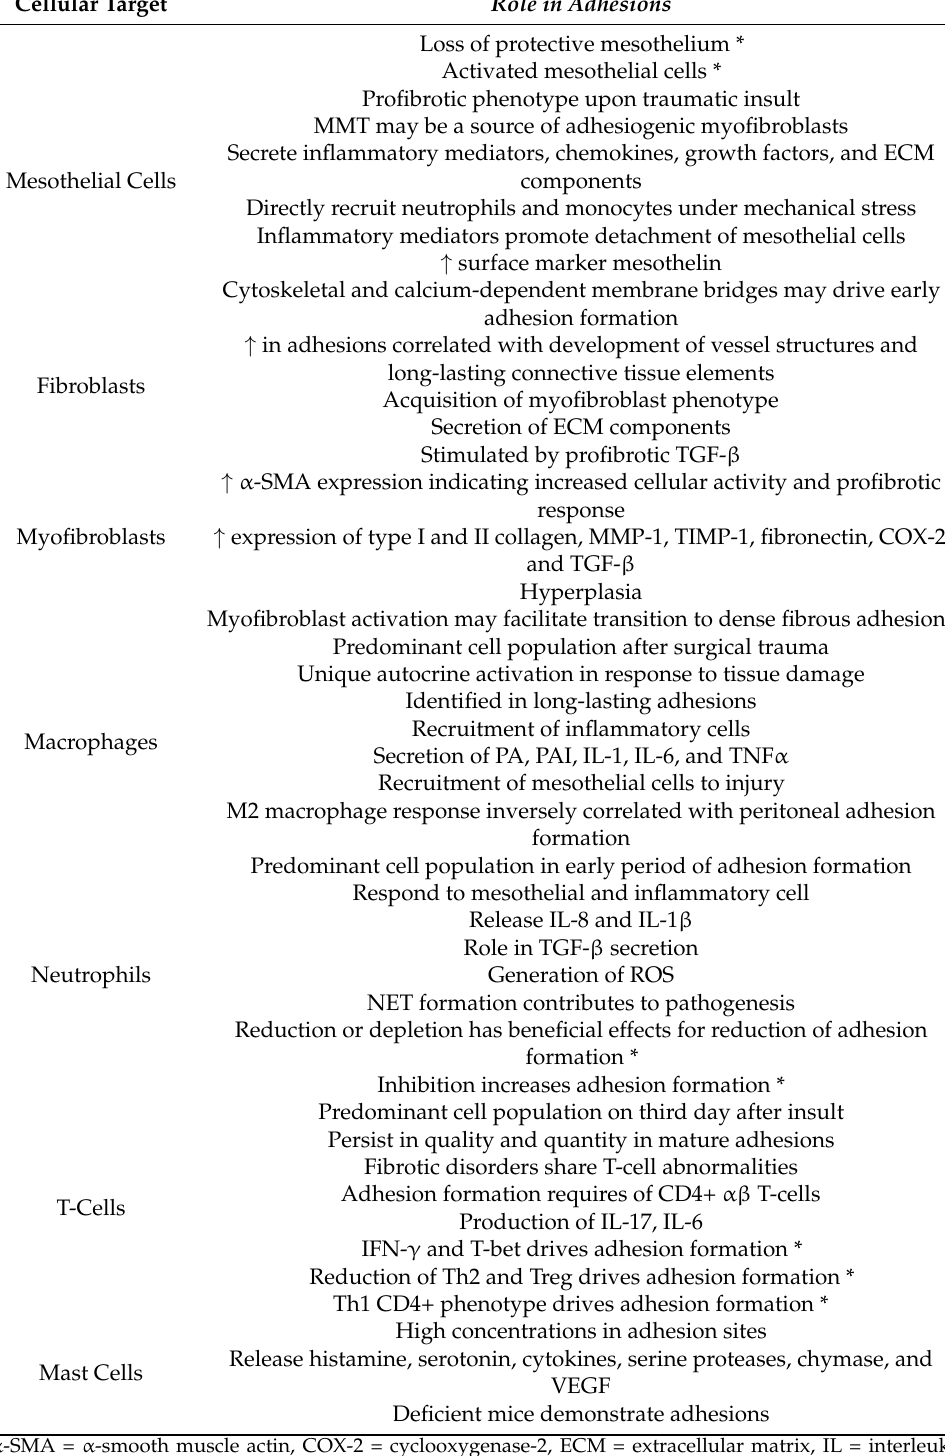
Table 1. Cellular mediators and their role in adhesion